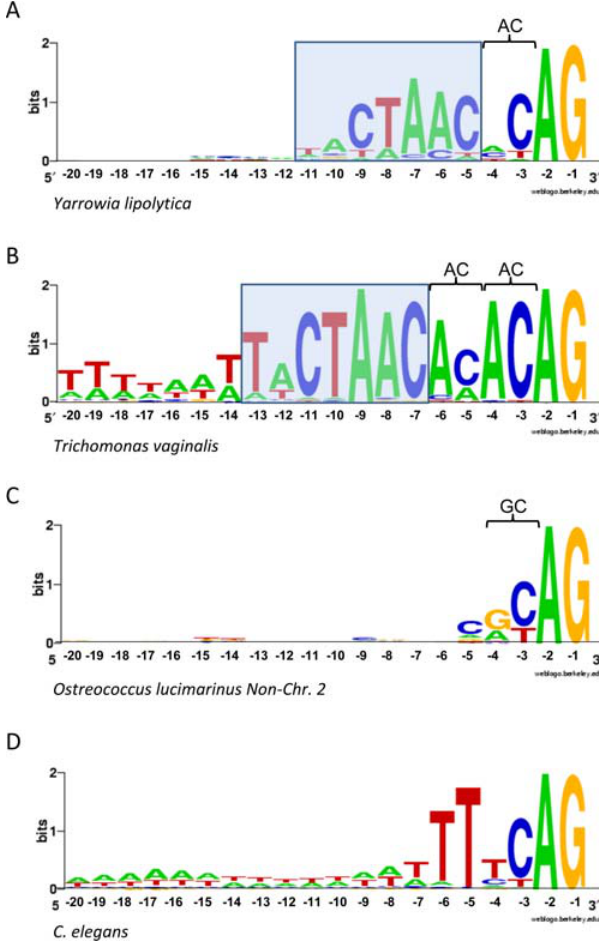
Figure 4. Highly constraint BP-AG distances in Y.lipolytica and T.vaginalis . (A) 3 9 intron boundary in Yaworria lipolytica . (B) 3 9 intron boundary in Trichomonas vaginalis . Note that the difference between both consensus is the existance of 1 ( Y. lipolytica ) or 2 ( T. vaginalis ) AC dinucleotides between the BP motif and the terminal AG. Consensus sequence for G. lamblia is similar to T. vaginalis . (C) 3 9 intron boundary for confirmed introns from non-chromosome 2 genes in O. lucimarinus . (D) 3 9 intron boundary in C. elegans